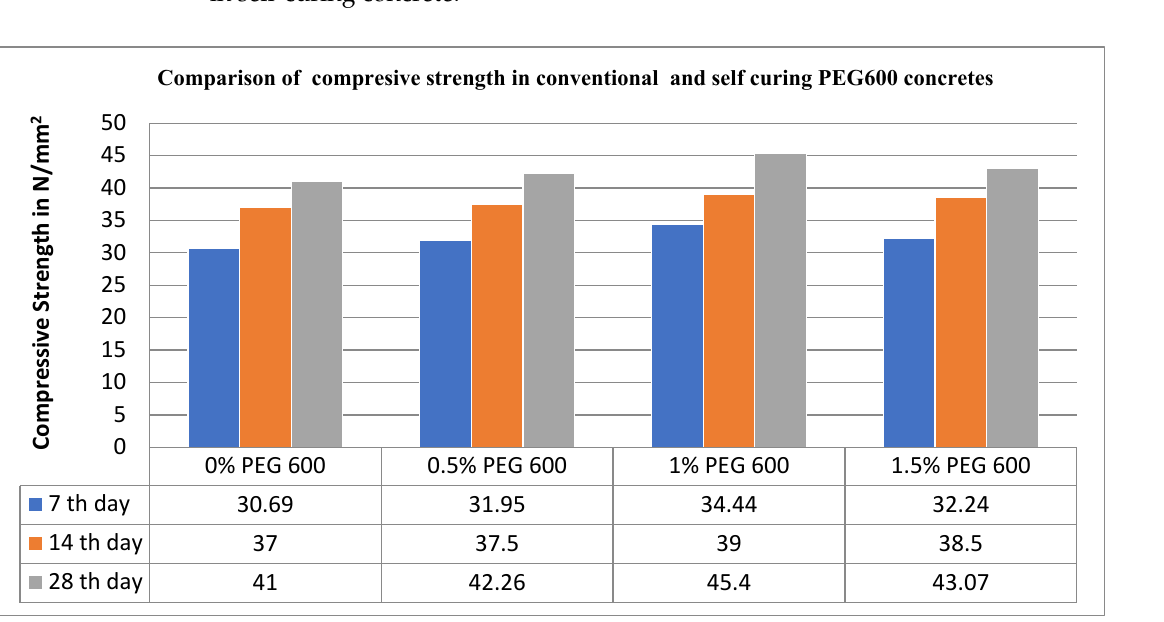
Comparison of flexural strength in conventional and self curing PEG600 concretes